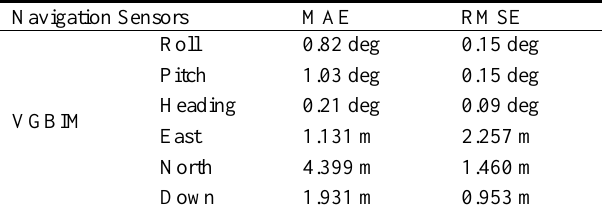
Table 6. The VGBIM navigation system accuracy